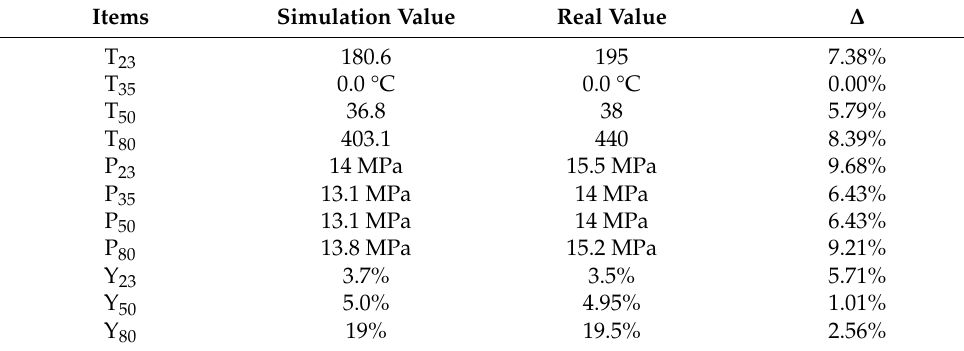
Table 2. Comparison of target values after data reconciliation.